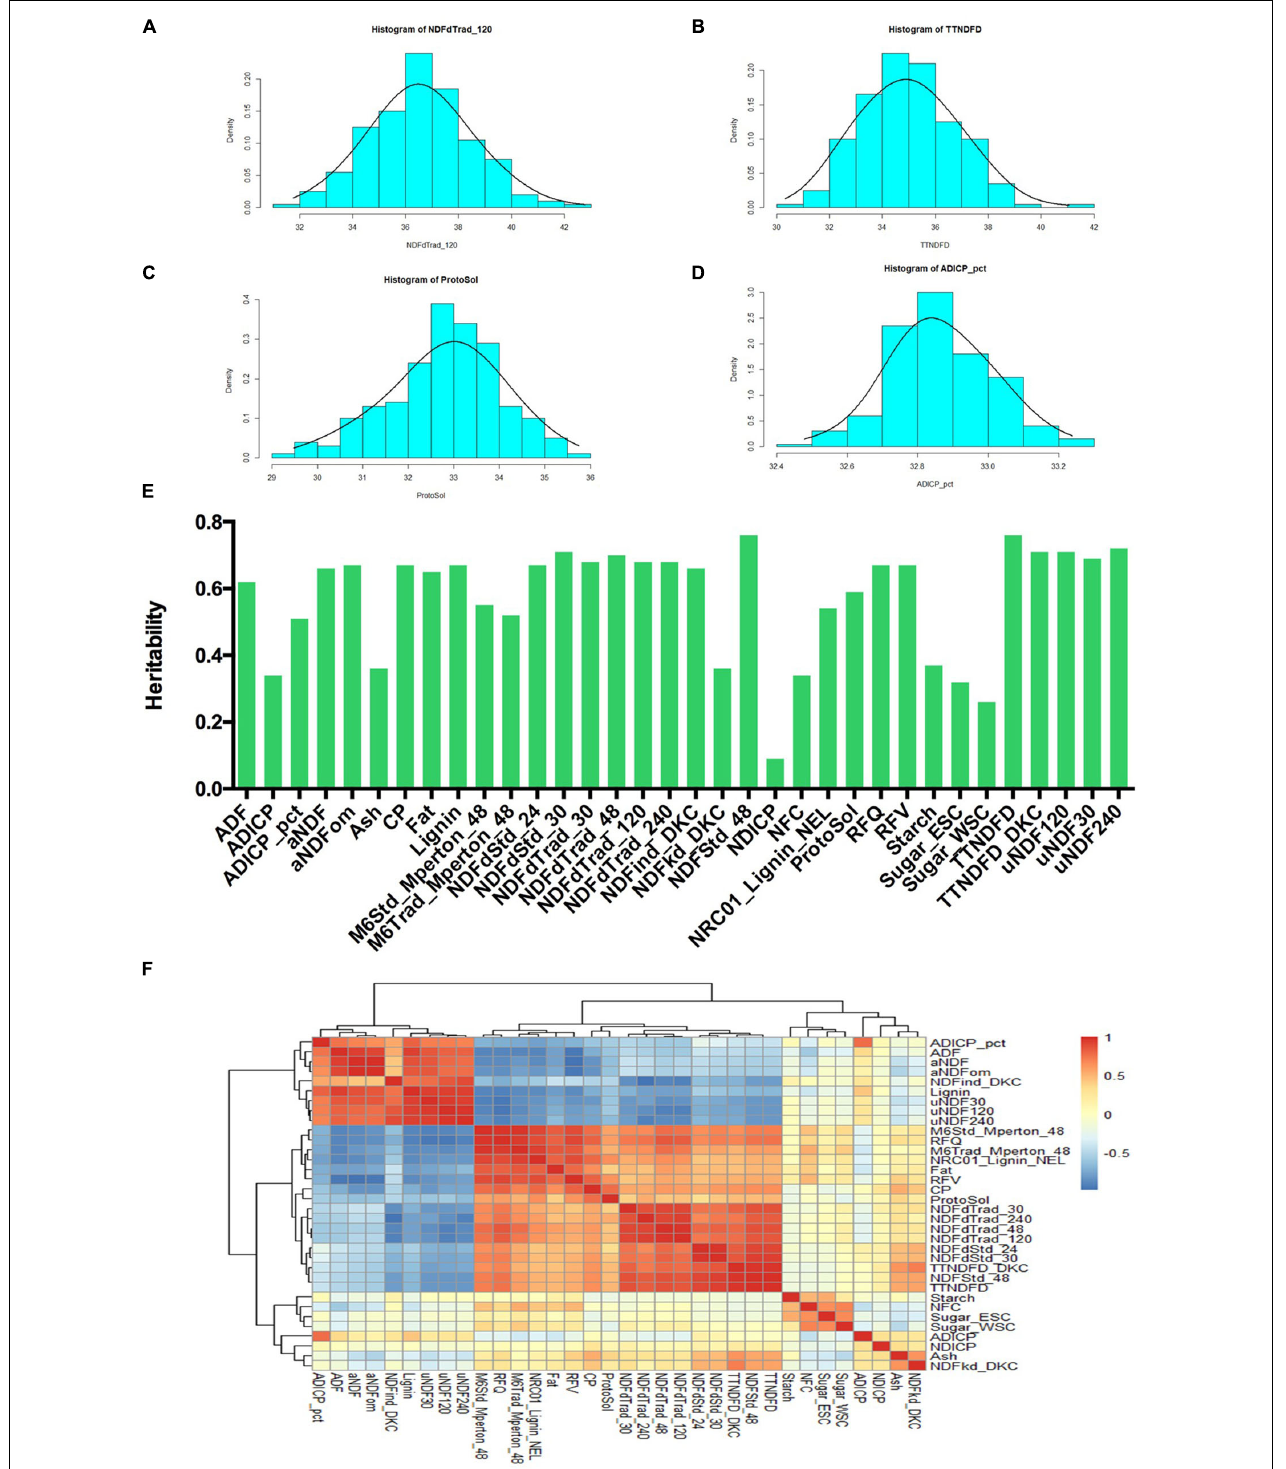
FIGURE 2 | Analysis of phenotypic variance in quality traits of alfalfa accessions. Histogram showed the phenotypic value of NDFdTrad_120 (A) , TTNDFD (B) , ProtoSol (C), and ADICP_pct (D) . (E) Broad sense heritability of 34 quality traits. All the 34 quality traits are listed on X-axis, and heritability value is shown on Y-axis. (F) Correlation analysis of 34 quality traits based on Pearson coefficients. Positive correlations were displayed in red, whereas negative correlations were showed in blue. All the 34 quality traits were hierarchically clustered as shown on the top and left side of the figure.